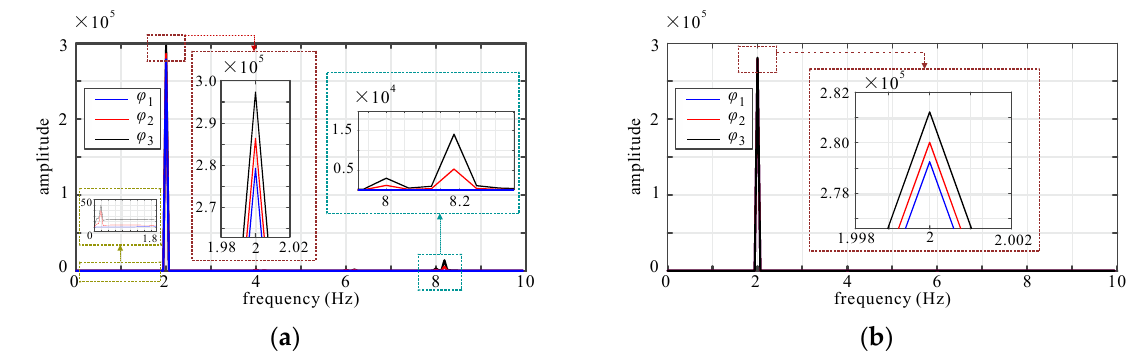
Figure 10. FFT of φ 1 , φ 2 and φ 3 : ( a ) Stance phase; ( b ) Swing phase. Figure 10. FFT of ϕ 1 , ϕ 2 and ϕ 3 : ( a ) Stance phase; ( b ) Swing phase.